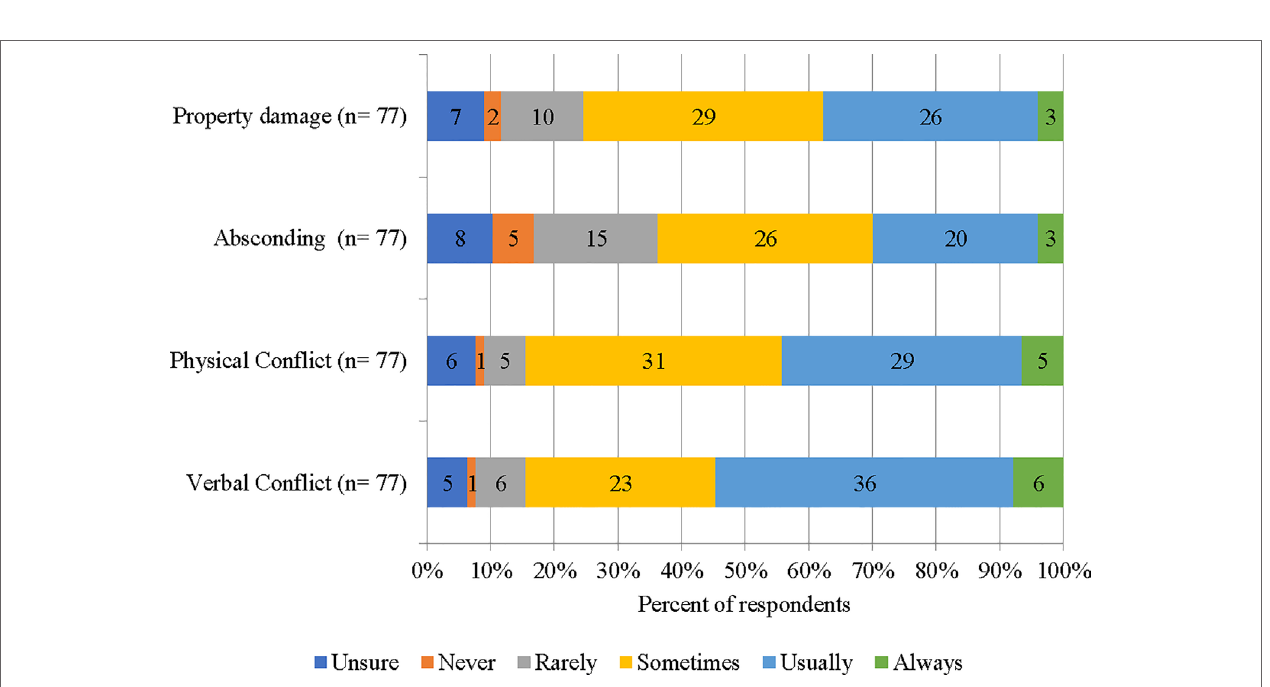
FIGURE 1 | Staff reports of the impact of Safewards on conflict